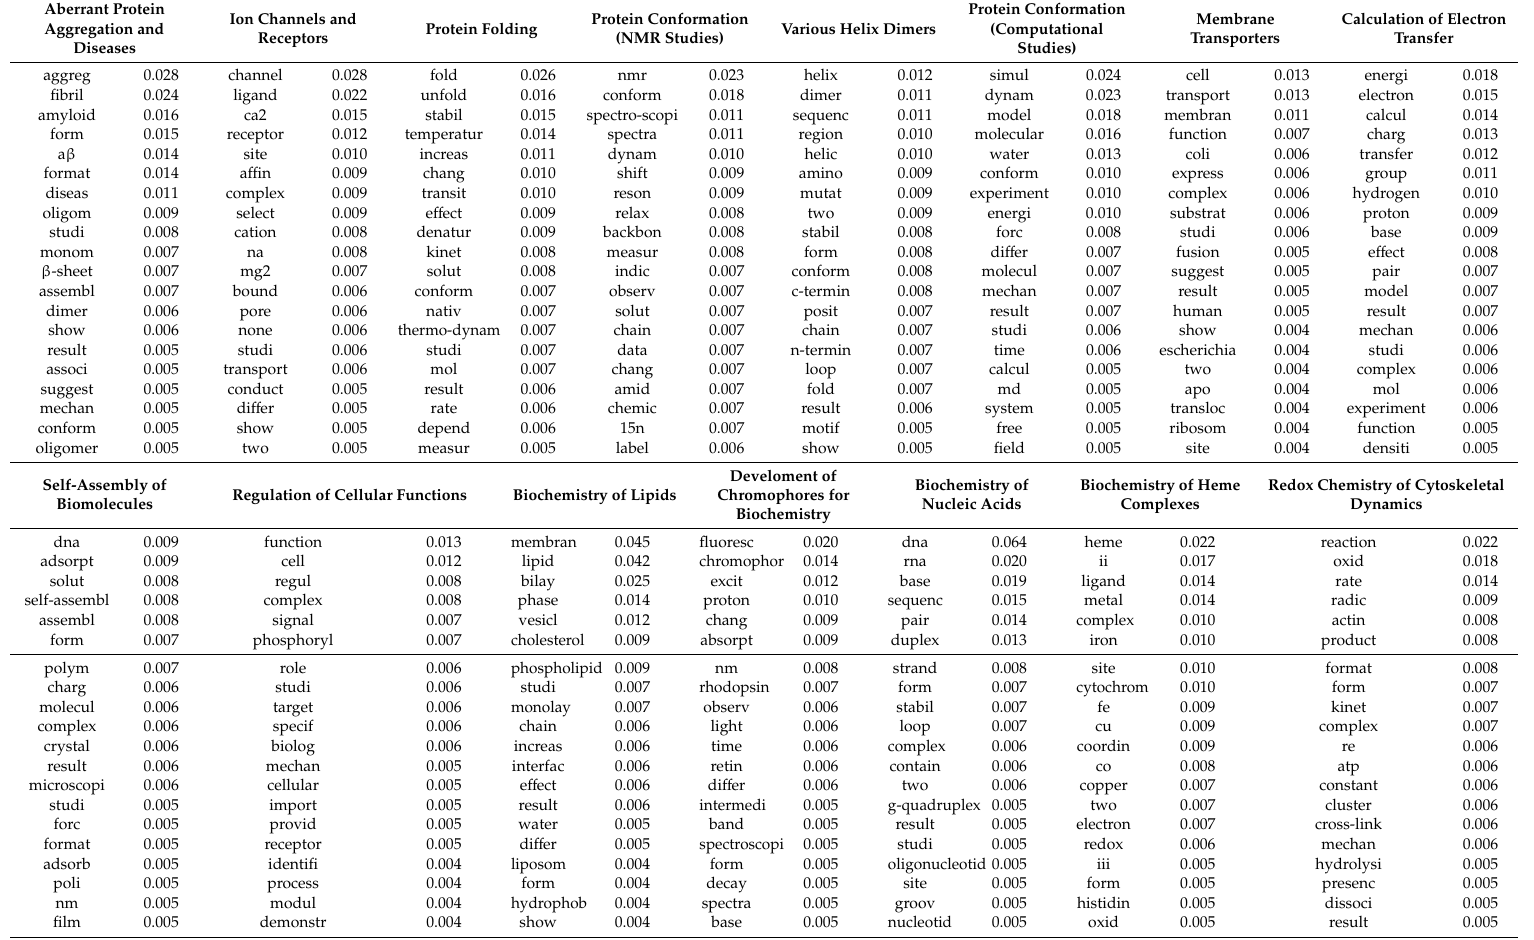
Table 3. Probability distribution of words by